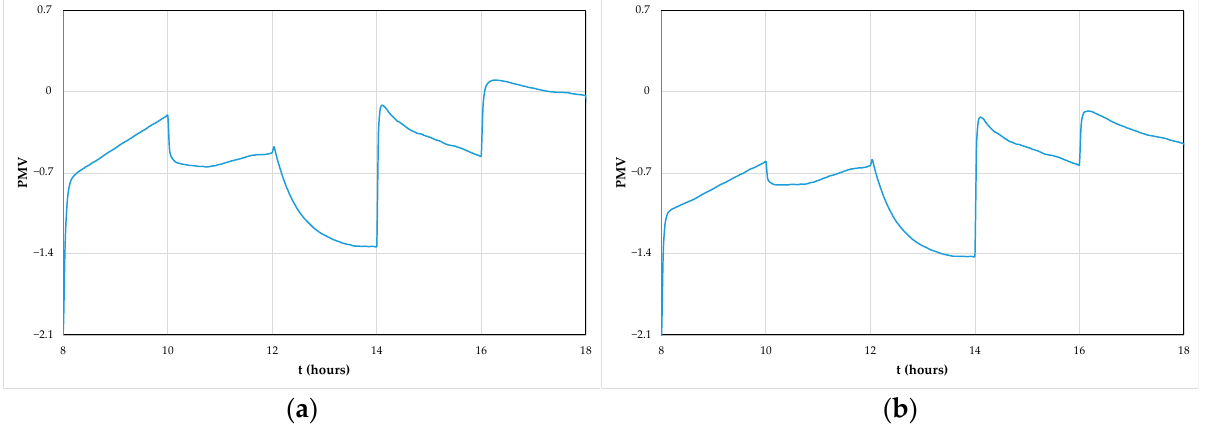
Figure 27. Evaluation of predicted mean vote (PMV) index for the Case G ( a ) and Case H ( b ).